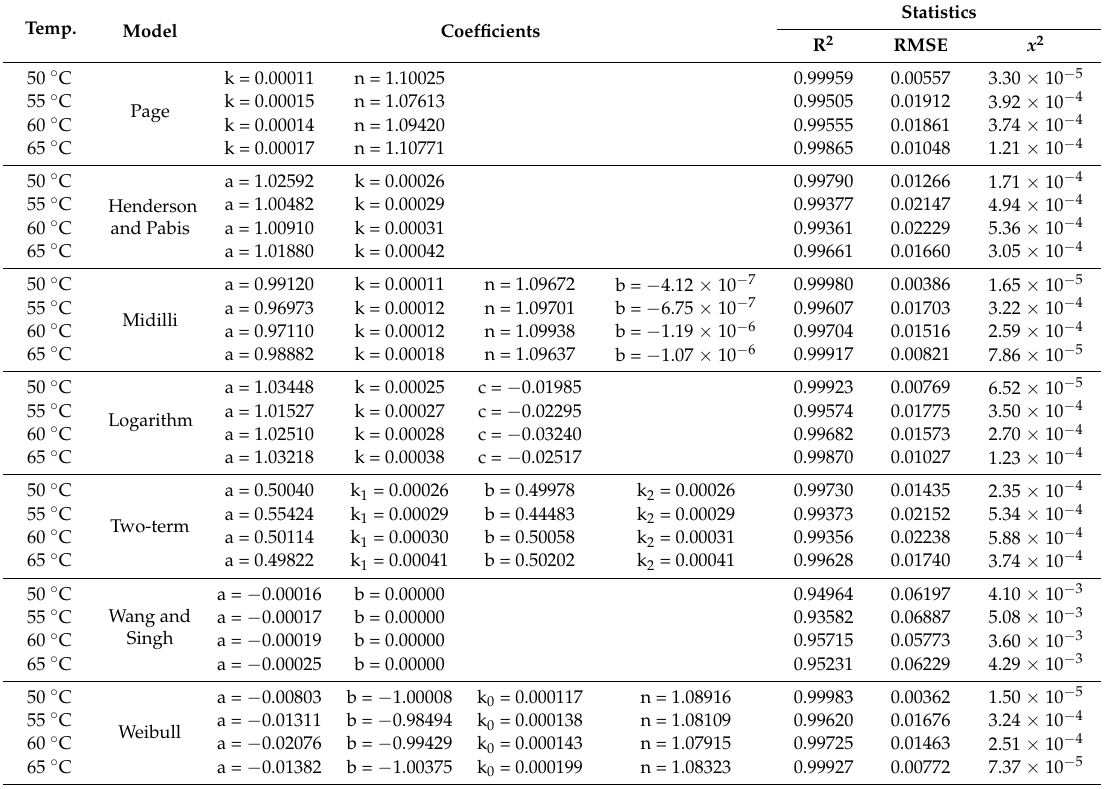
Table 2. Result of statistical analyses on the modeling of moisture content and drying time.